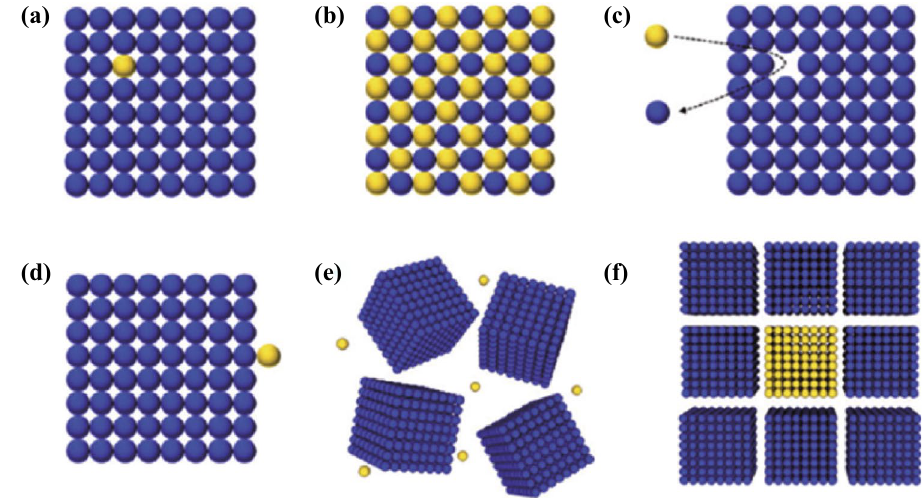
Fig. 17 Scheme of possible strategies to tune doping in nanoparticle-based solution-processed nanomaterials: a extrinsic dopants during syn- thesis; b stoichiometry control; c post-synthesis atomic substitution; d surface chemistry; e dopant additives during consolidation; f modulation doping. Adapted with permission from Ref.